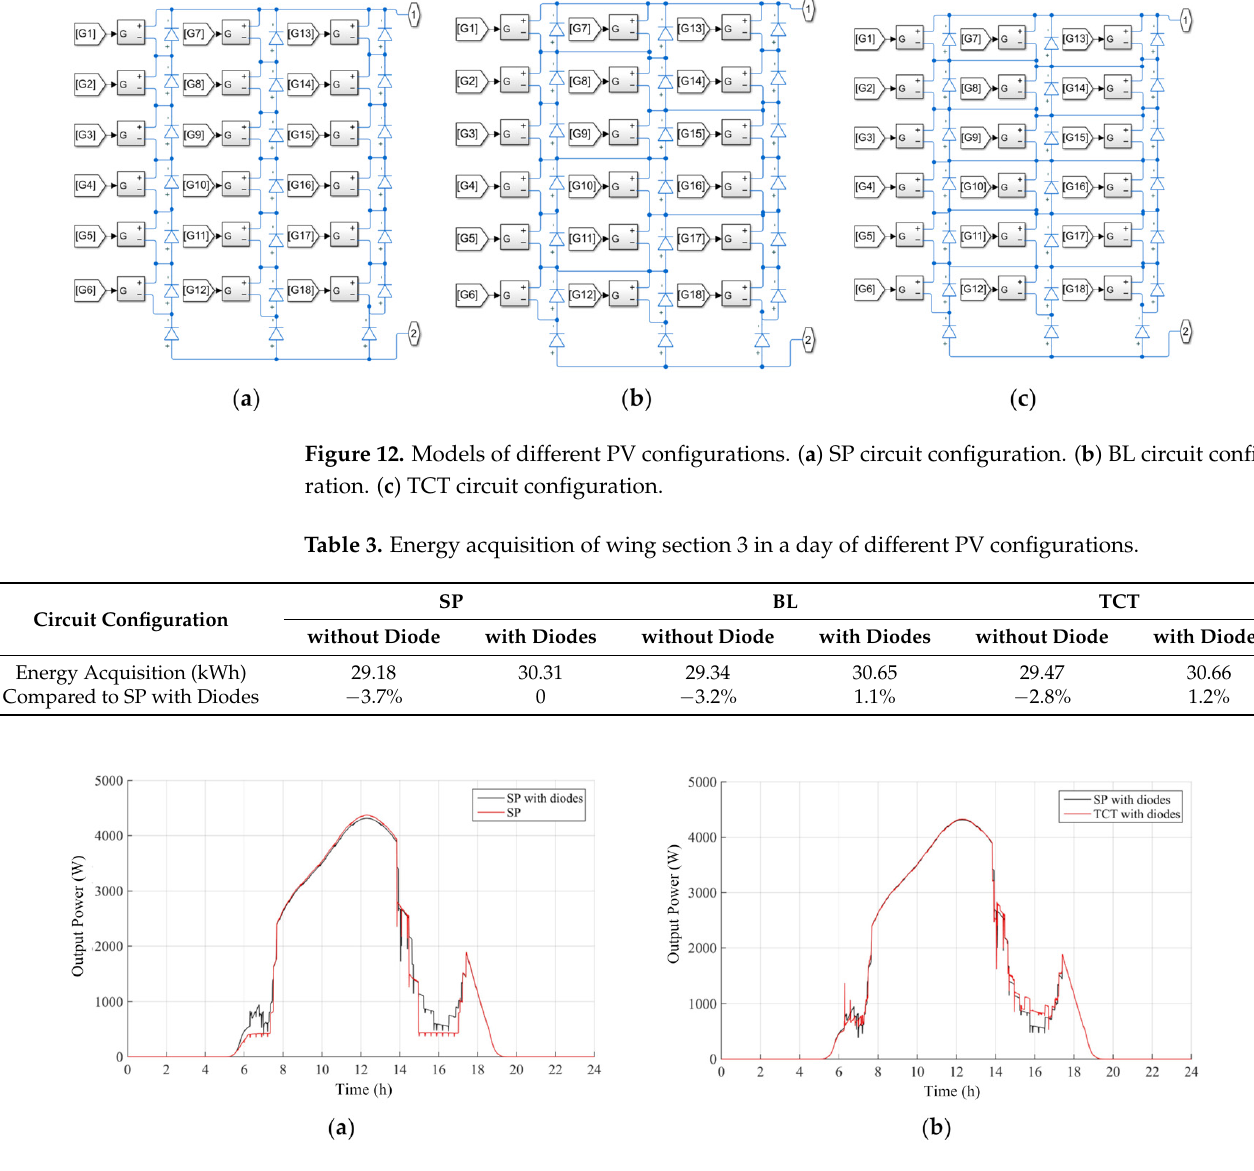
Figure 13. Energy acquisition of different circuit configurations. ( a ) Output power of wing section 3. ( b ) Output power of wing section